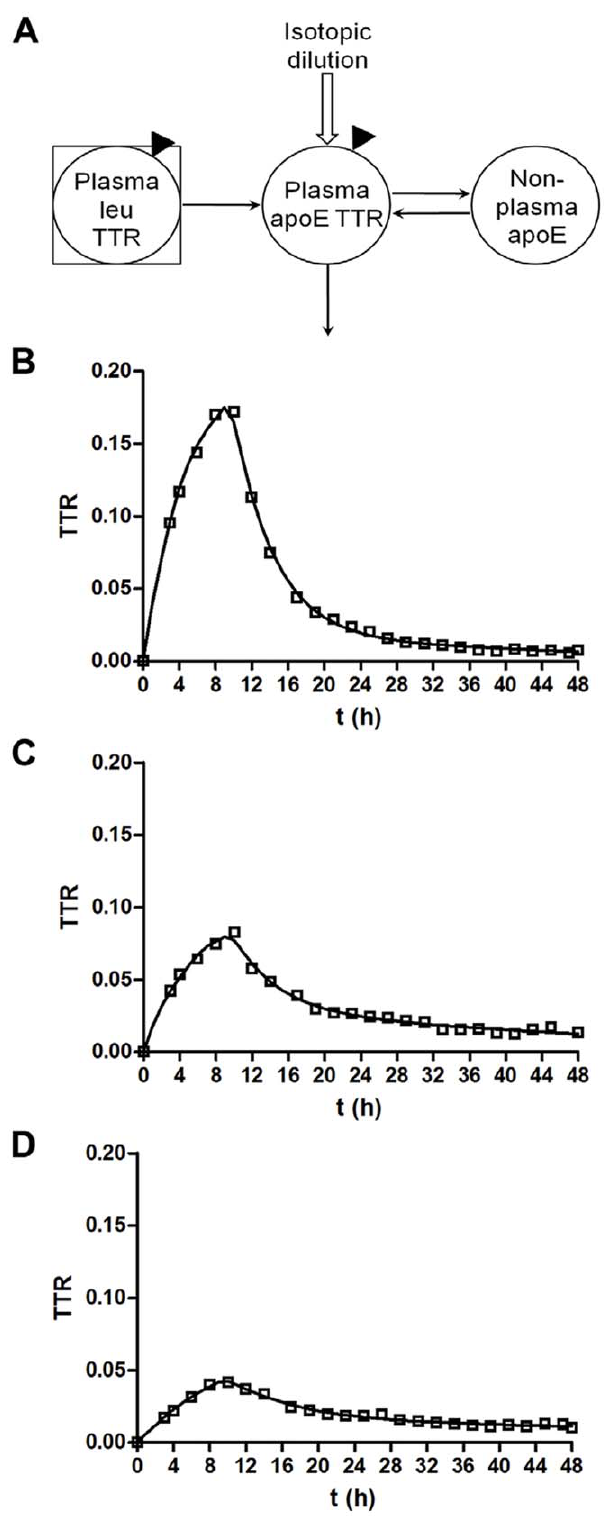
Figure 2. Representative compartmental model analyses of plasma ApoE. A . Peripheral ApoE compartmental model has 4 adjustable parameters: the plasma ApoE FTR, the rate constants for bi- directional exchange with the non-plasma space, and a scaling factor to account for isotopic dilution. B . ApoE4 peptide LAVYQAGAR from an ApoE2/4 subject. C. ApoE3 peptide LGADMEDVcGR from an